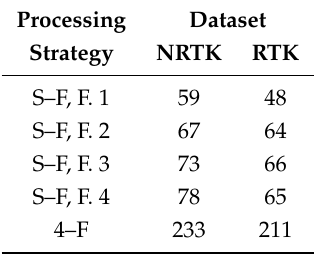
Table 3. Number of images used for the creation of the photogrammetric model of façades.